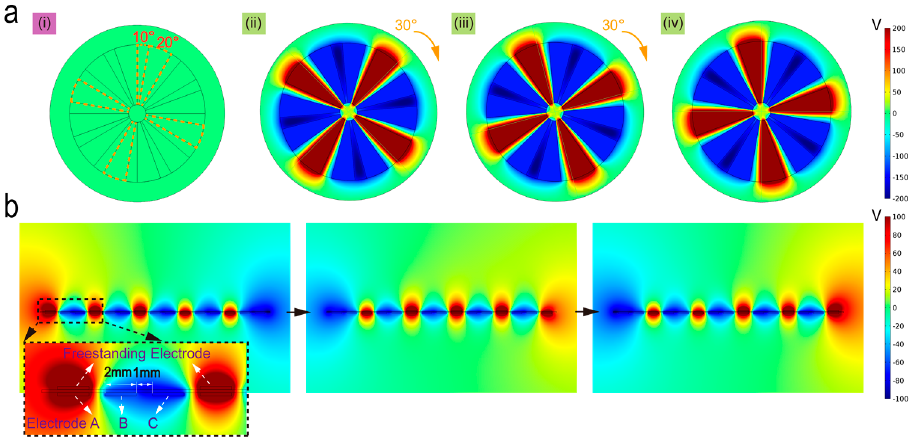
Figure 2. COMSOL simulation of the SPVS with different structure mode. ( a ) Potential simulation of disc structure ( i ), rotating from the initial state ( ii ) to final state ( iv ) under the rotation step of 30°. ( b ) Potential simulation of strip structure under three different states. The inset picture illustrates the position relationship between the freestanding electrode and the bottom electrodes.